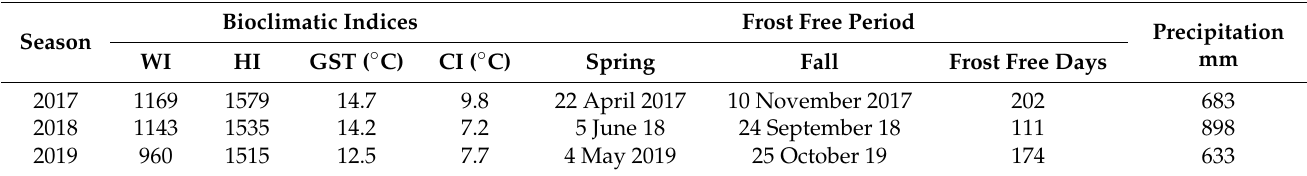
Table 2. Bioclimatic indices calculated each season under